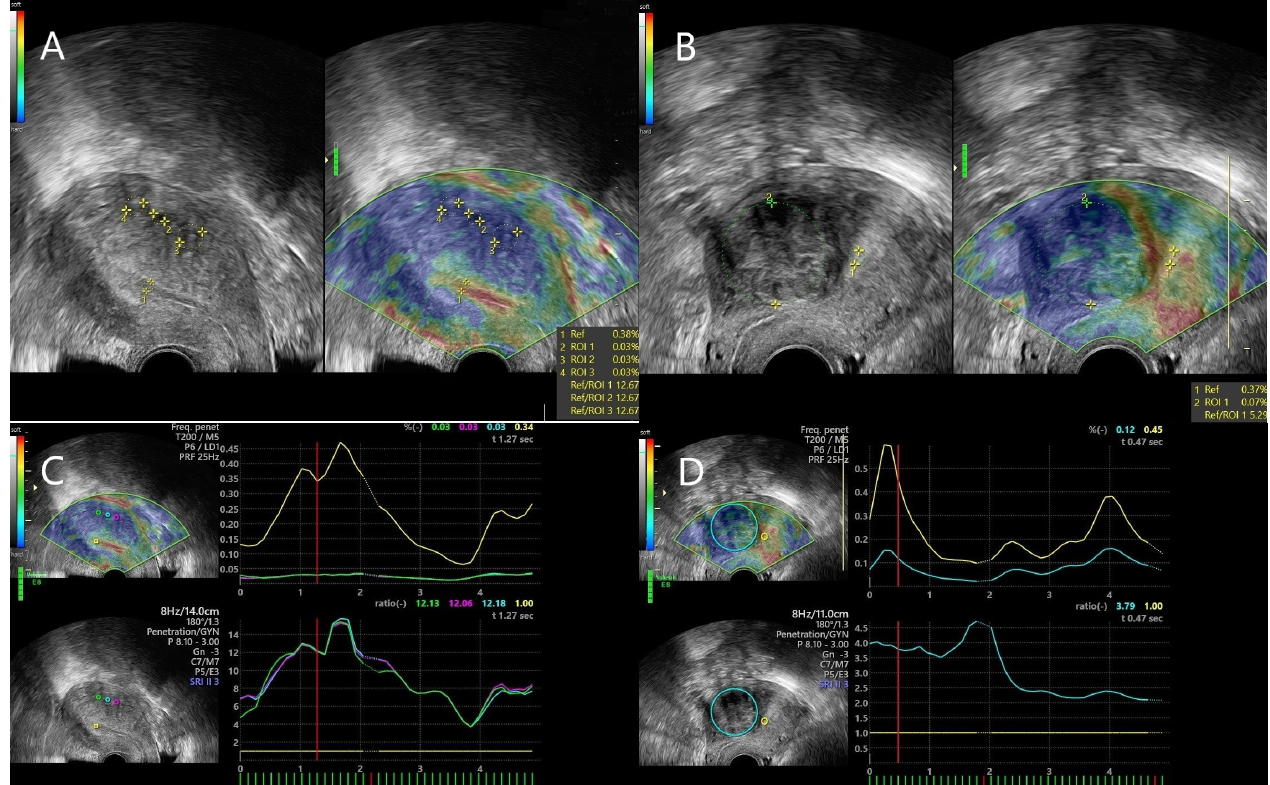
Figure 3. ( A ) ROI placement for comparison of tissular stiffness between healthy referral tissue and adenomyotic tissue. ( B ) ROI placement for comparison of tissular stiffness between healthy referral tissue and uterine fibroid. ( C ) Graphic representation of the elastogram obtained from an adenomyotic lesion: the line plots depict the strain ratio value of the lesional tissue (green, blue and purple lines) in comparison with the one of the referral tissue (yellow line), in accordance with standard qualitative criteria, as implied by the elastography software ( D ) Graphic representation of the elastogram obtained from a uterine fibroid: the line plots depict the strain ratio value of the lesional tissue (blue line) in comparison with the one of the referral tissue (yellow line), in accordance with standard qualitative criteria, as implied by the elastography